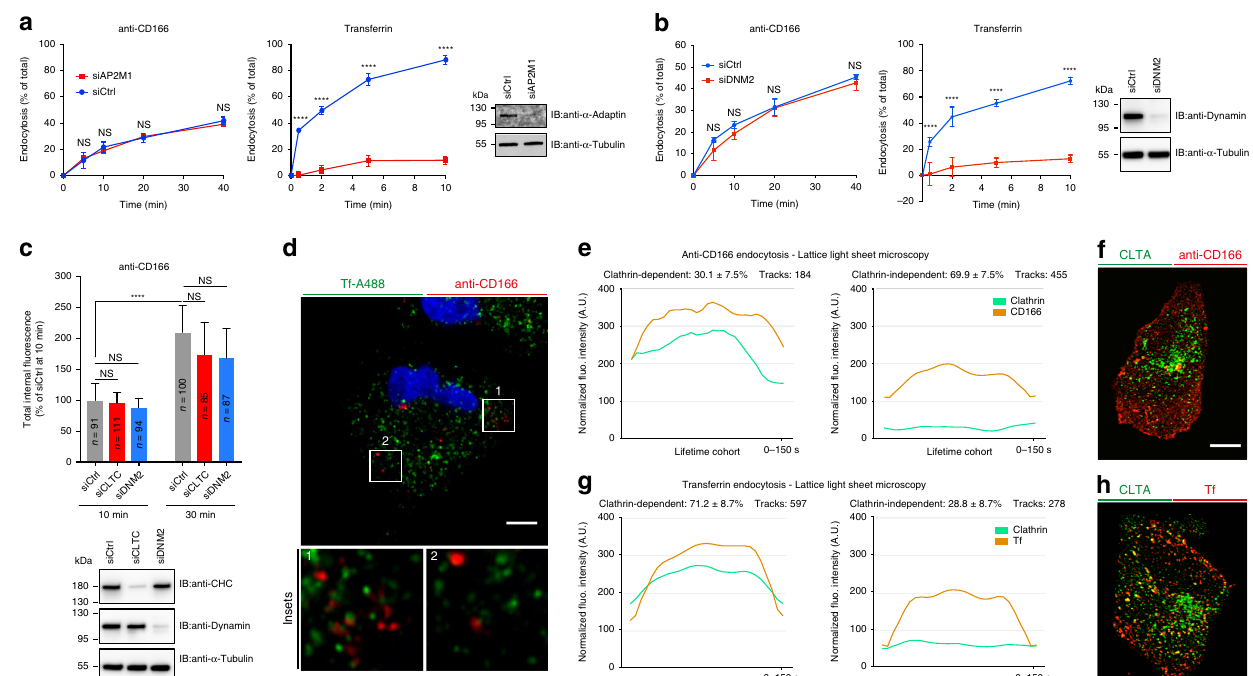
Fig. 1 CD166 is endocytosed in a clathrin- and dynamin-independent manner. HeLa cells treated with negative control (siCtrl, a – c ), or µ 2-adaptin (siAP2M1, a ), dynamin-2 (siDNM2, b – c ), or clathrin heavy chain (siCLTC, c ) siRNAs. a , b Measure of anti-CD166 and transferrin (Tf) endocytosis by loss of surface assay in fl ow cytometry. a Number of independent experiments: anti-CD166, n = 3; Tf, n = 4. b Three independent experiments. NS, not signi fi cant. **** P < 0.0001 (RM two-way ANOVA with Bonferroni ’ s multiple comparison test). c Continuous uptake of anti-CD166 antibody for 10 and 30 min. Internal fl uorescence quanti fi ed from confocal images and plotted as the relative percentage of siCtrl condition at 10 min. n cells, two independent experiments. NS not signi fi cant. **** P < 0.0001 (Kruskal – Wallis test with Dunn ’ s multiple comparison post hoc test, two-sided). The Western blots against α -adaptin ( a ), dynamin ( b , c ), and clathrin heavy chain ( c ) document the ef fi ciency of siRNAs. Loading control, α -tubulin. d Continuous co-uptake of anti- CD166 antibody (red) and fl uorescent Tf (green) for 5 min in HeLa cells. No co-localization between the two markers (see insets). Representative of three independent experiments. e – h Endocytosis imaged by lattice light-sheet microscopy on live cells. Full 3D volume of 60 planes per U2OS cell acquired within 3 s. Average endocytic intensity traces per lifetime, and classi fi cation of endocytic events for anti-CD166 ( e ) and Tf ( g ) uptake. Green, endogenous genome-edited CLTA-mRFP; Orange, cargo. Lifetime cohorts of endocytic trajectories show a “ dome ” -shaped intensity pro fi le of cargoes and co-tracking or not with clathrin. f , h 2D projections of acquired 3D stacks of cargo (red), clathrin (green), and overlay (yellow). Representative of ten experiments. All ten experiments were used for quanti fi cations ( e , g ). Scale bars, 5 µ m ( d ), 10 µ m ( f , h ). Data are mean ± s.e.m. Source data are provided as a Source Data fi le and in Supplementary Fig. 11